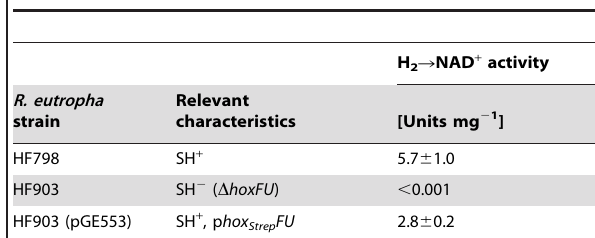
Table 1. SH activities in CTAB-treated cells of different R. eutropha derivatives grown in FGN